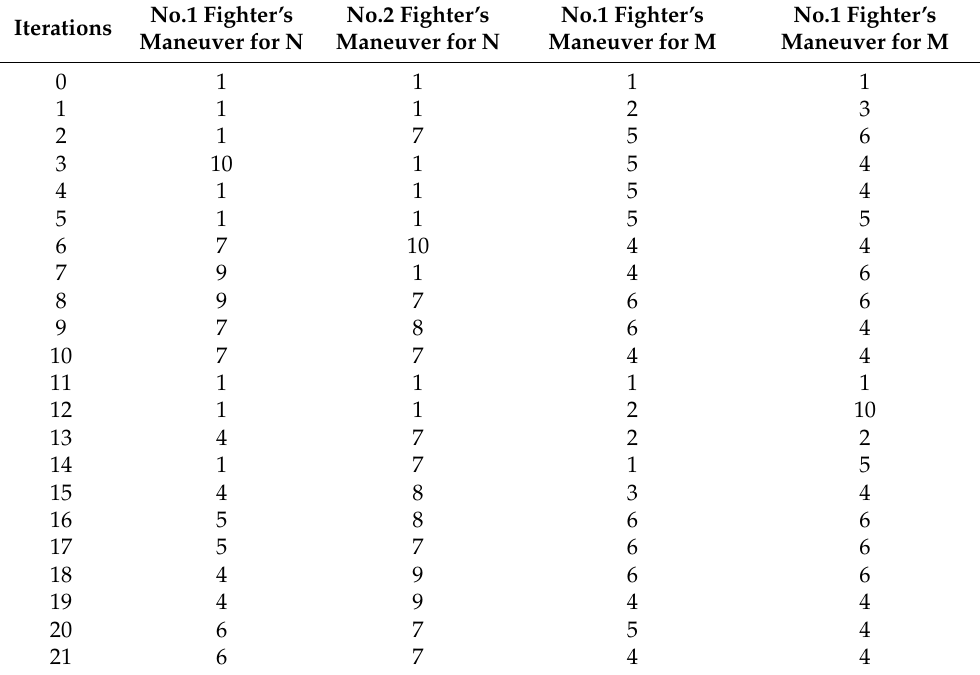
Table 6. Results of maneuver